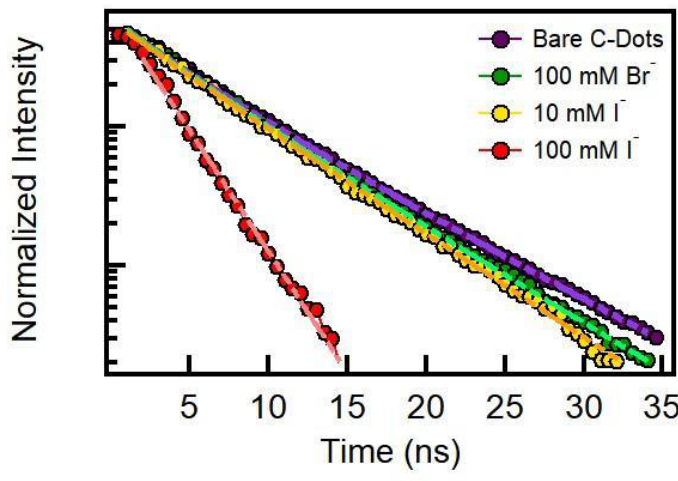
Figure 4. Normalized decay fluorescence excited at 440 nm of bare C-dots (purple curve), of C-dots with 100 mM of Br − (green curve), with 10 mM (yellow curve) and 100 mM (red curve) of I − with the respective least-squares fitting curves.